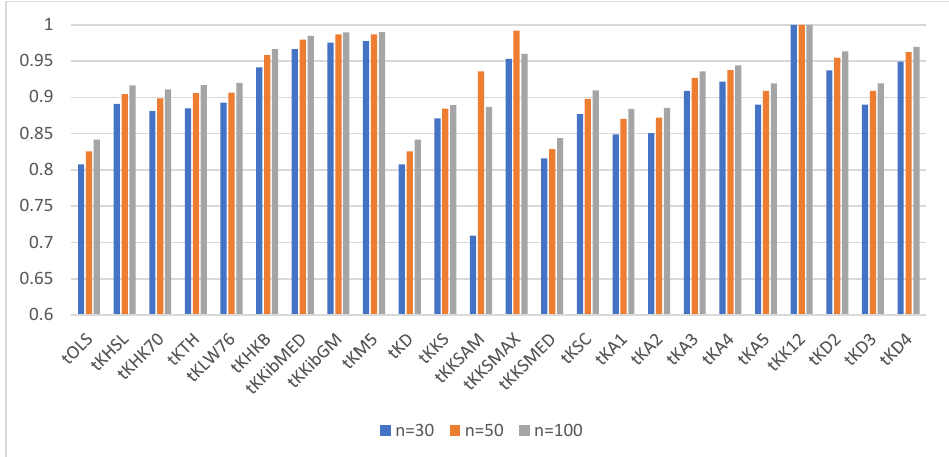
Figure 4. Power of the test for correlation coefficient 0.95 and q = 4.